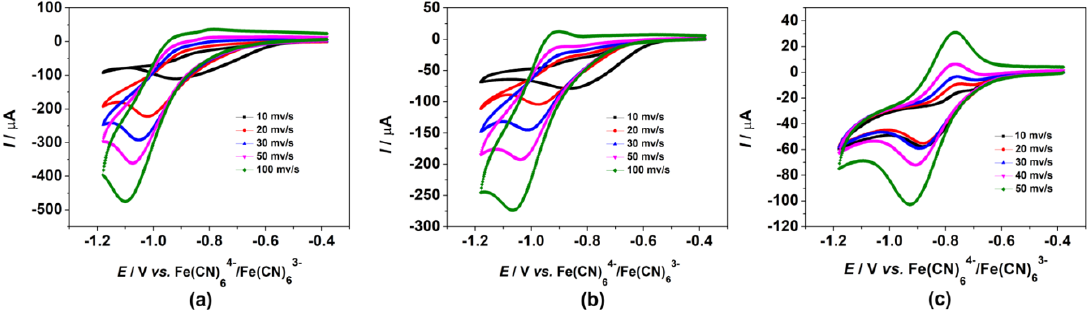
Figure 6. CVs of (BPEI/ARS) 120 ( a ), (BPEI/(ARS+PSS)) 120 ( b ) and ((BPEI+ARS)/PSS) 120 ( c ) on ITO-coated glass in 0.1 M NaCl.